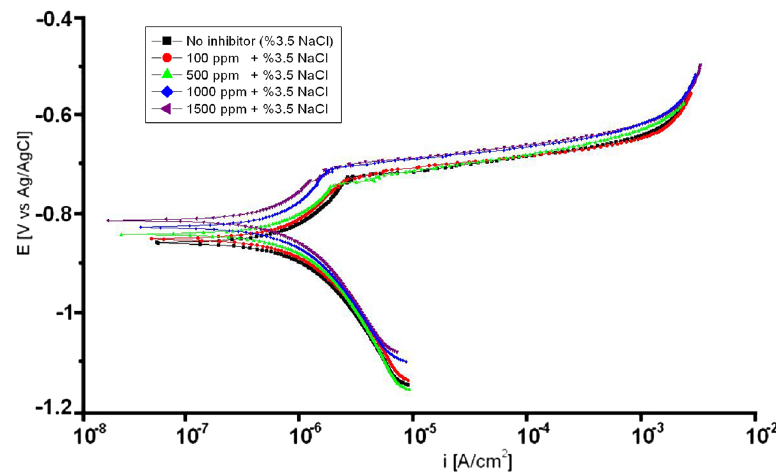
Figure 2. Potentiodynamic polarisation curves for Al-2007 alloy in 3.5% NaCl at various concentrations of mad